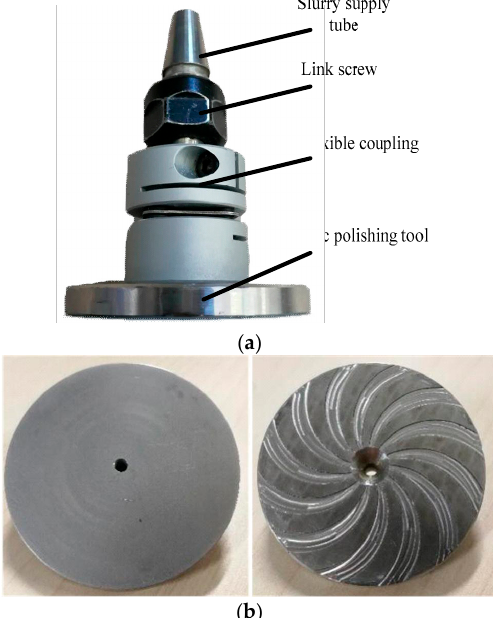
Figure 1. Schematic and physical diagram of a disc hydrodynamic polishing (DHDP) experimental system: ( a ) polishing module, ( b ) disc polishing tool.